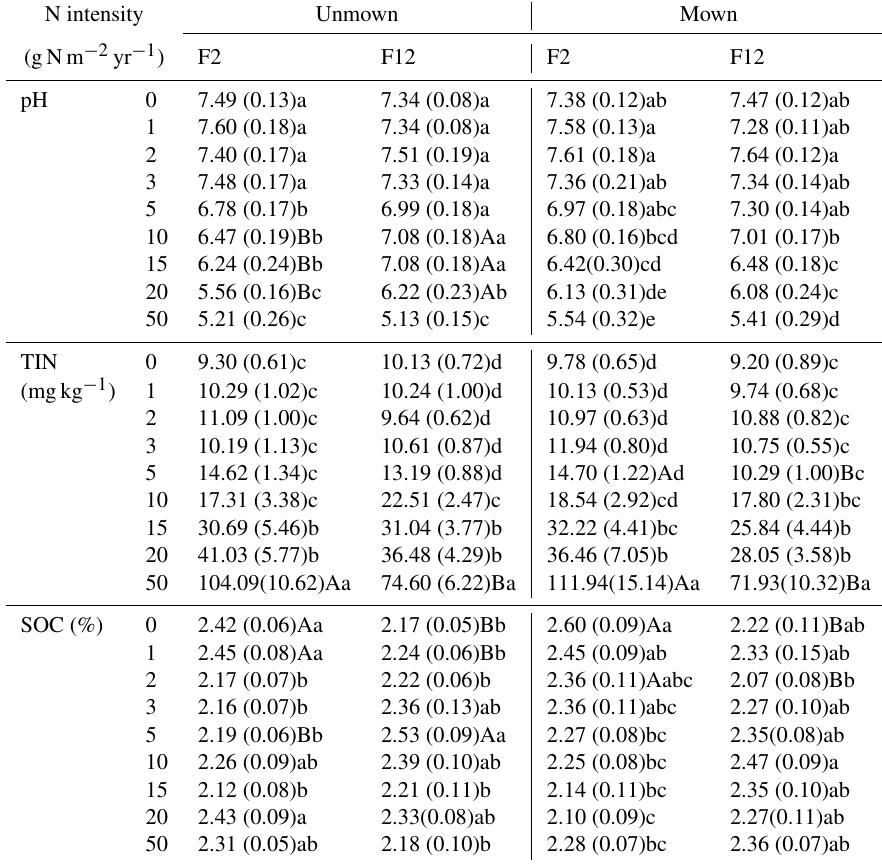
Table 1. Effects of N addition and mowing on soil pH, soil organic carbon (SOC), and total inorganic nitrogen (TIN). Data shown are the mean values, and the values in parentheses are standard errors ( n = 10), which were previously reported in Wang et al. (2018). N